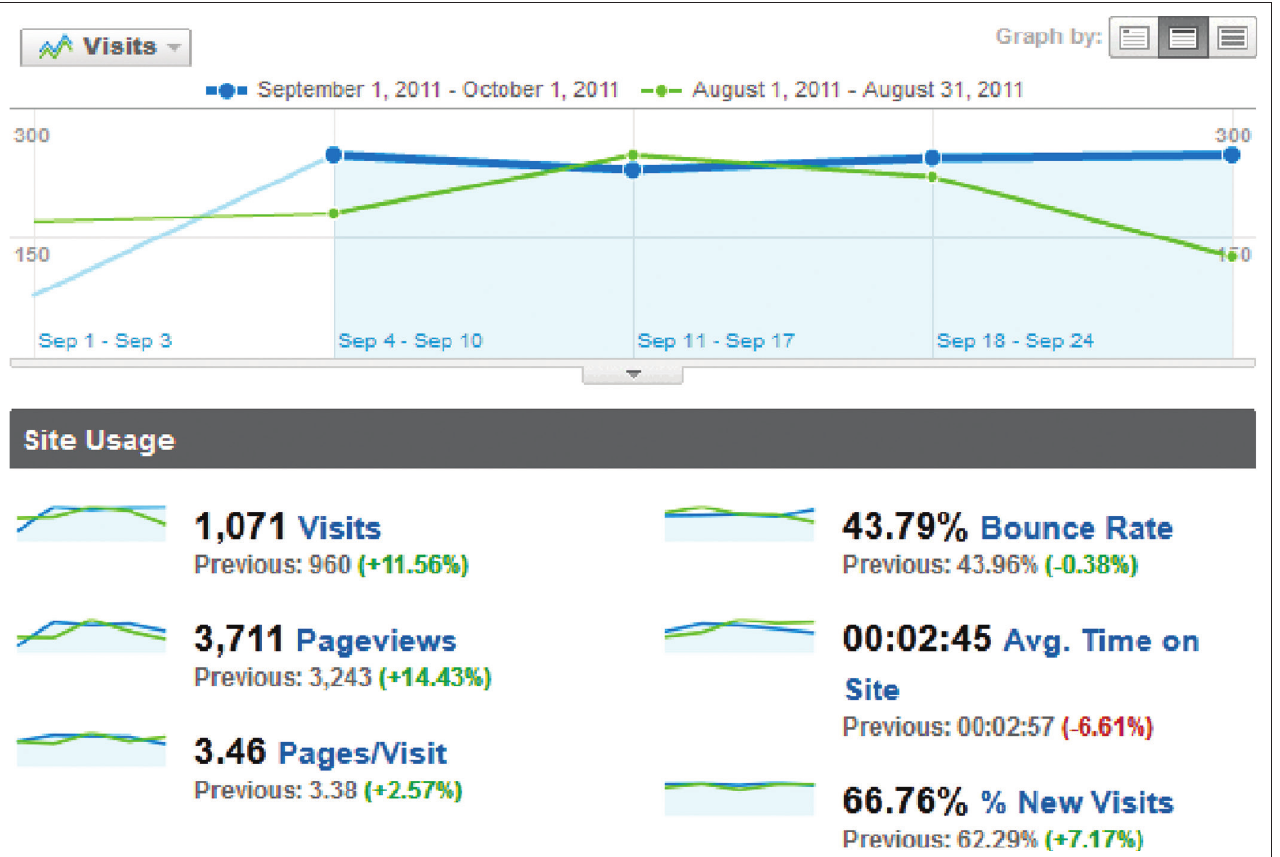
FIGURE 4: Total website traffic: September 2011 compared to August